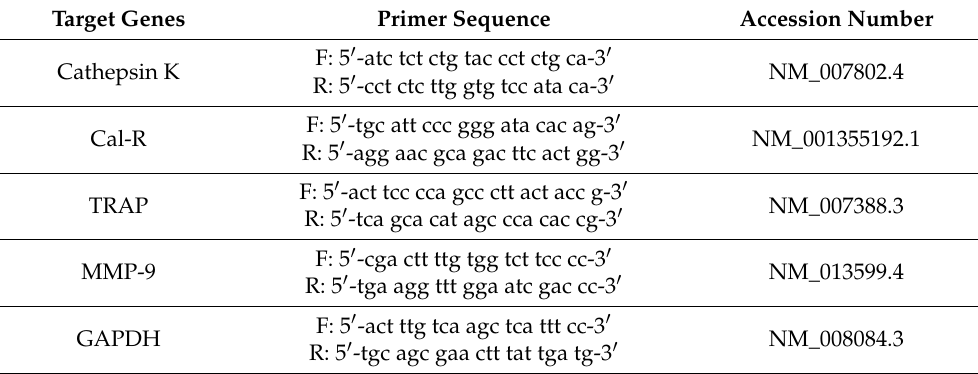
Table 1. RT-PCR primer